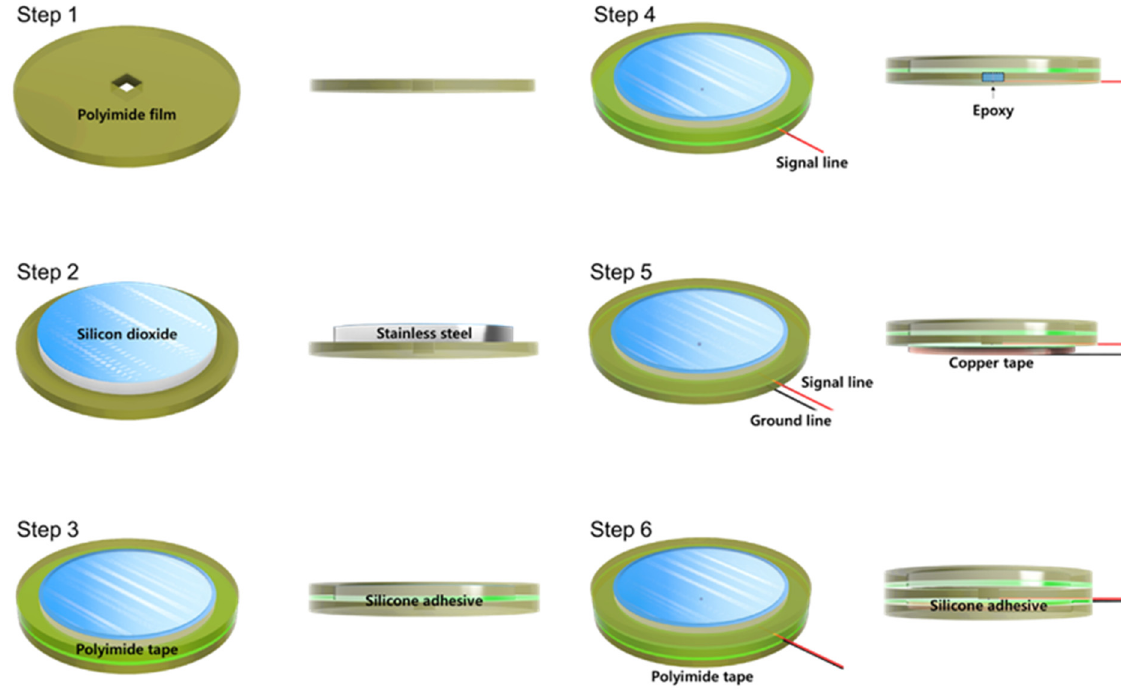
Figure 2. Fabrication process flow of silicon − dioxide − coated electrode.